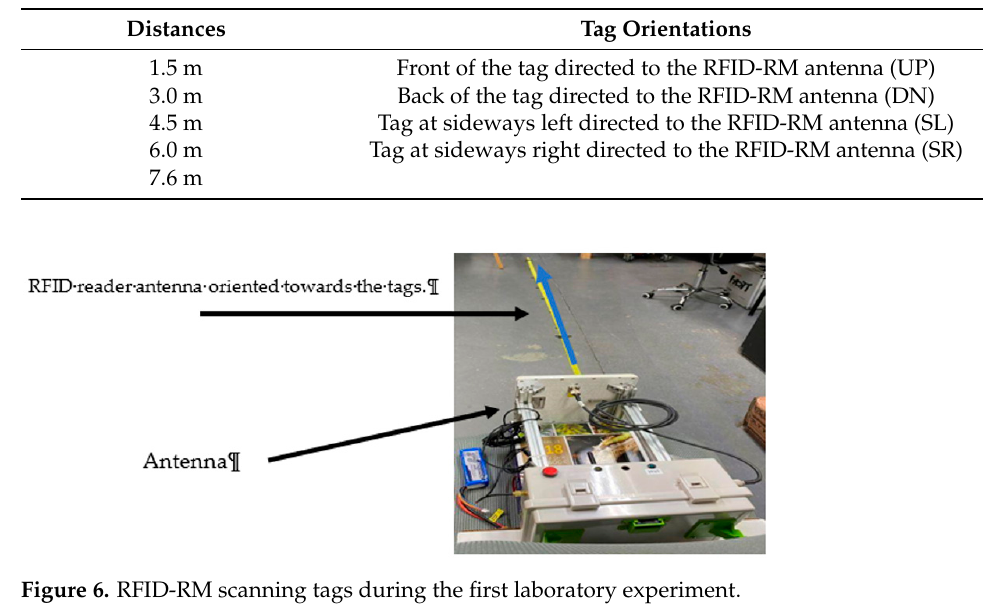
Figure 5. Tags positioned in an ( a ) upward orientation and ( b ) downward orientation (i.e., upper surface pointed away from reader). Table 2. Factors (2) evaluated in the first laboratory experiment for a total of nine treatments.